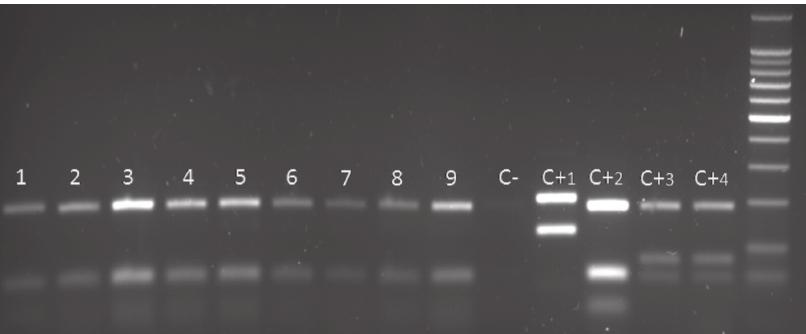
Fig. 1. – Application of RFLP analysis of the ITS1-PCR analysis on positive amastigotes slides from Chichaoua province in